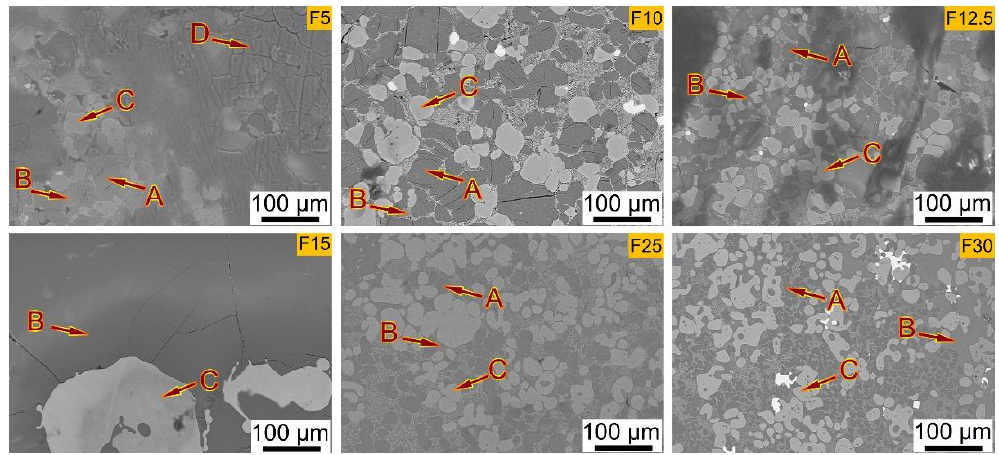
Figure 7. SEM images with the magnification of 200 times for the Fe 2 O 3 addition amount of 5, 10, 12.5, 15, 25 and 30 g.